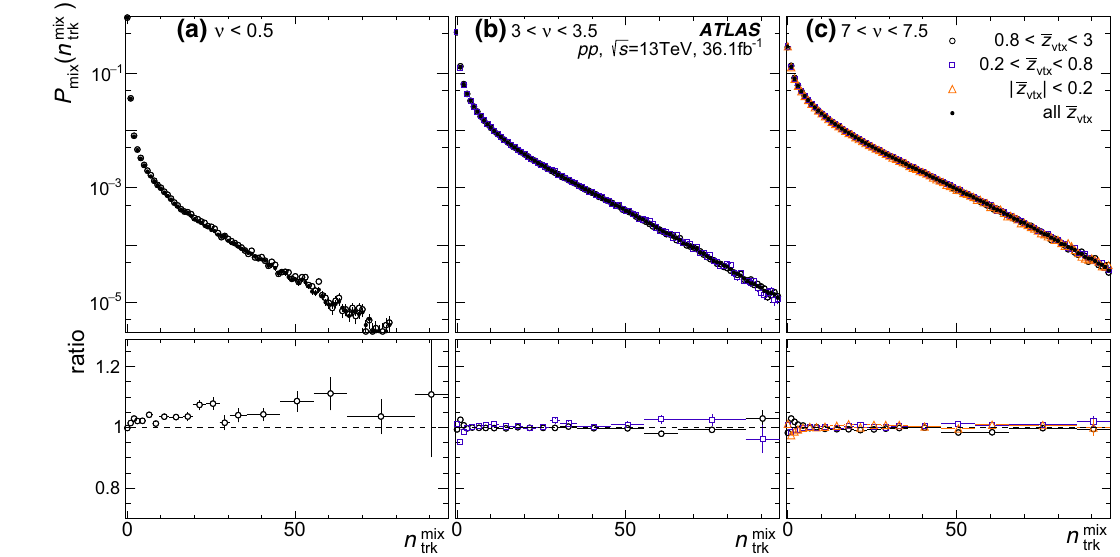
Fig. 4 The upper panels show the probability distributions for the n mix measured without any restriction on ¯ z vtx (filled markers) as well as in three different ¯ z vtx intervals (open markers). From left to right, the panels correspond to ν ranges of a ν < 0 . 5, b 3 < ν < 3 . 5 and c